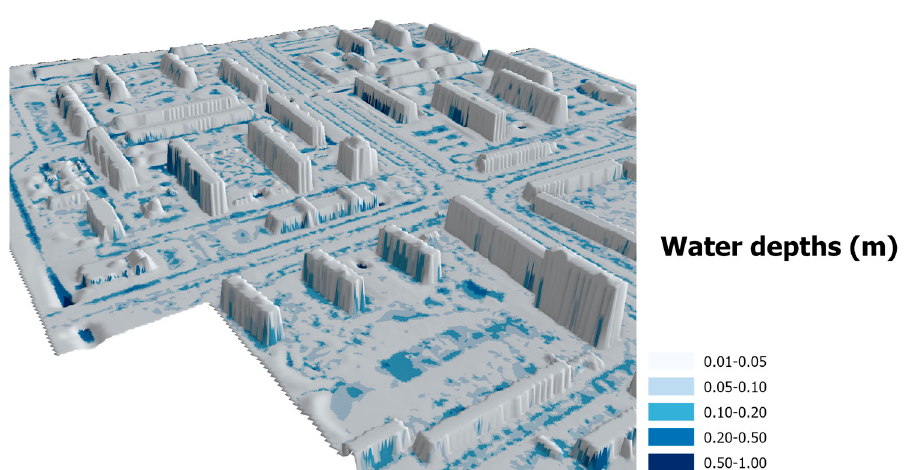
Figure 19. Water depth after a one-hour 50-year return period rain event in the Malmö test area. The raster rendering causes water close to the walls to appear on the walls, which is really standing water right by the building. The area and visualisation direction are the same as shown in Figure 14.